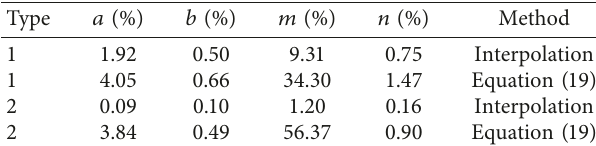
Table 4: Errors caused by comparing with FEA